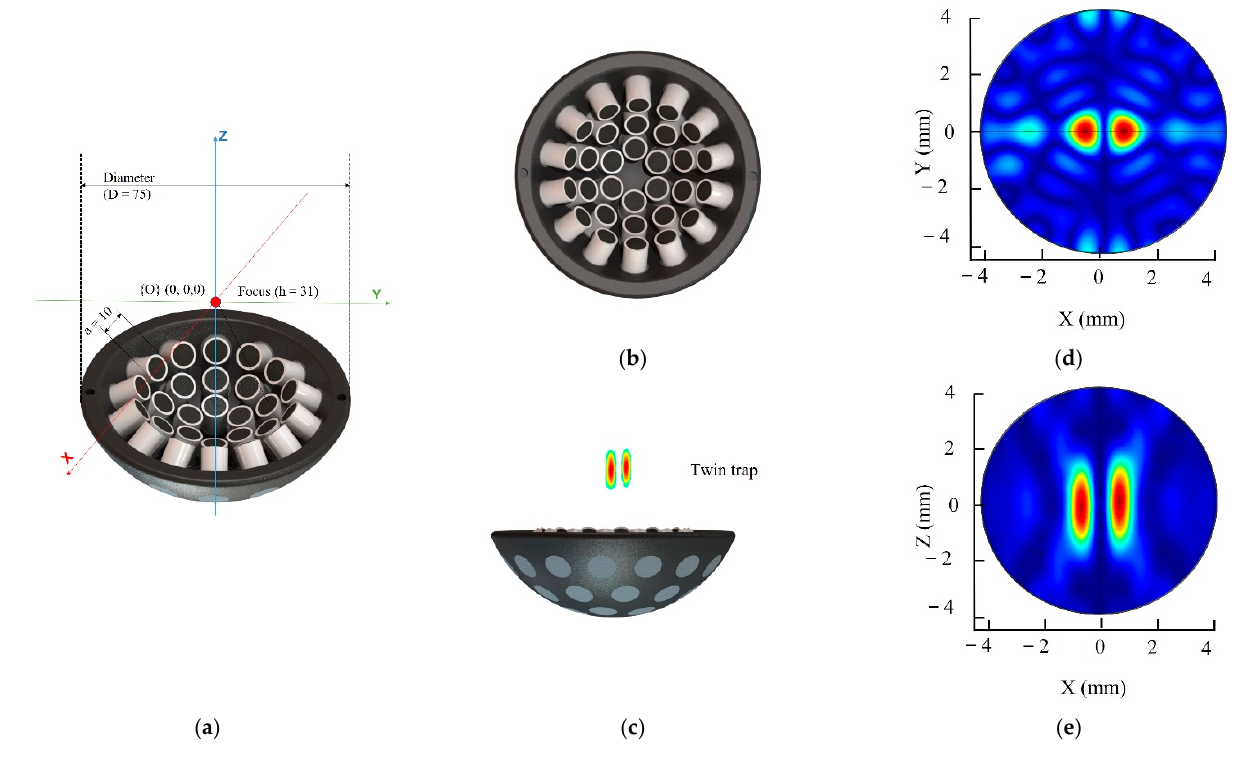
Figure 2. Single ‐ side UTs array geometry design: ( a ) isometric view; ( b ) lateral views; and ( c ) top view; ( d ) Absolute acoustic radiation pressure field in the O ‐ XY plane; ( e ) Absolute acoustic radiation pressure field in the O ‐ XZ plane. Table 2. Specifications of AcoMan.